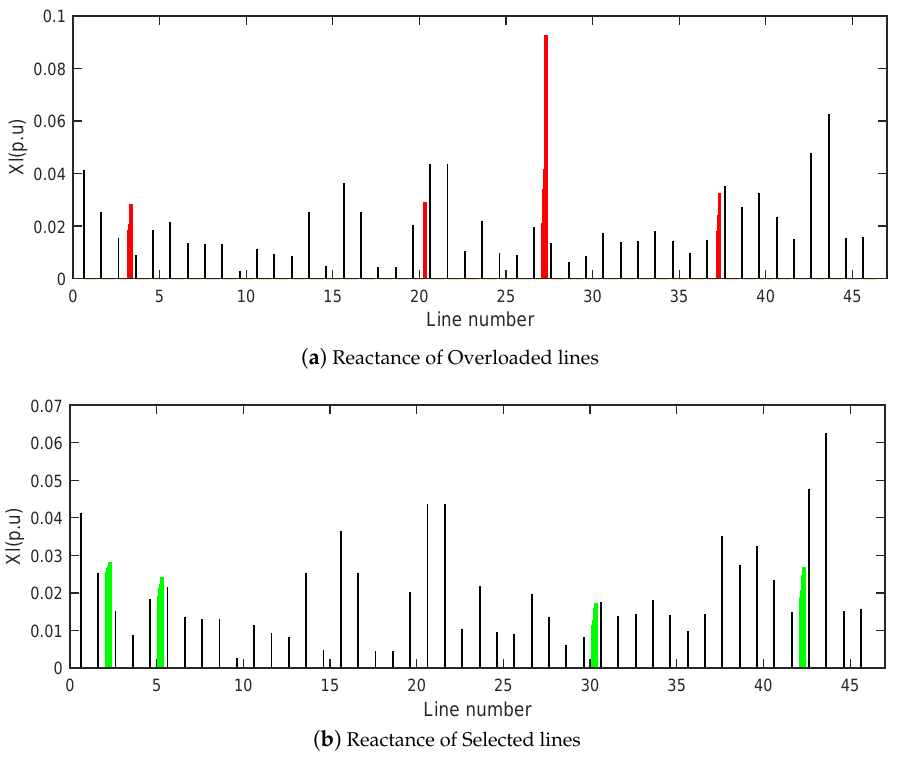
Figure 8. Reactance variation of lines in IEEE39 bus system.